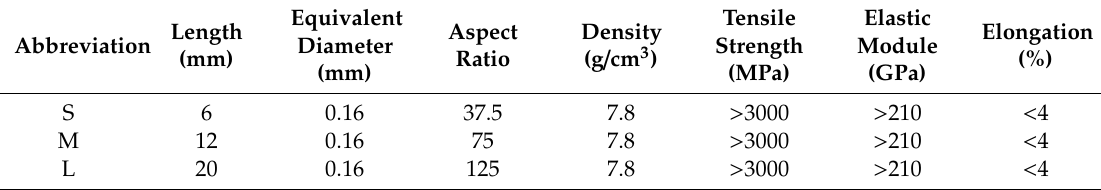
Table 2. Properties of steel fibers. S: short, M: medium, L: